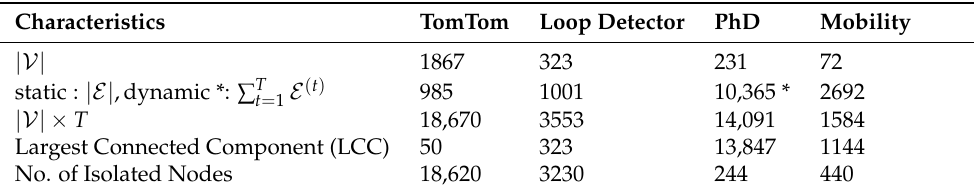
Table 1. Characteristics of the study datasets.